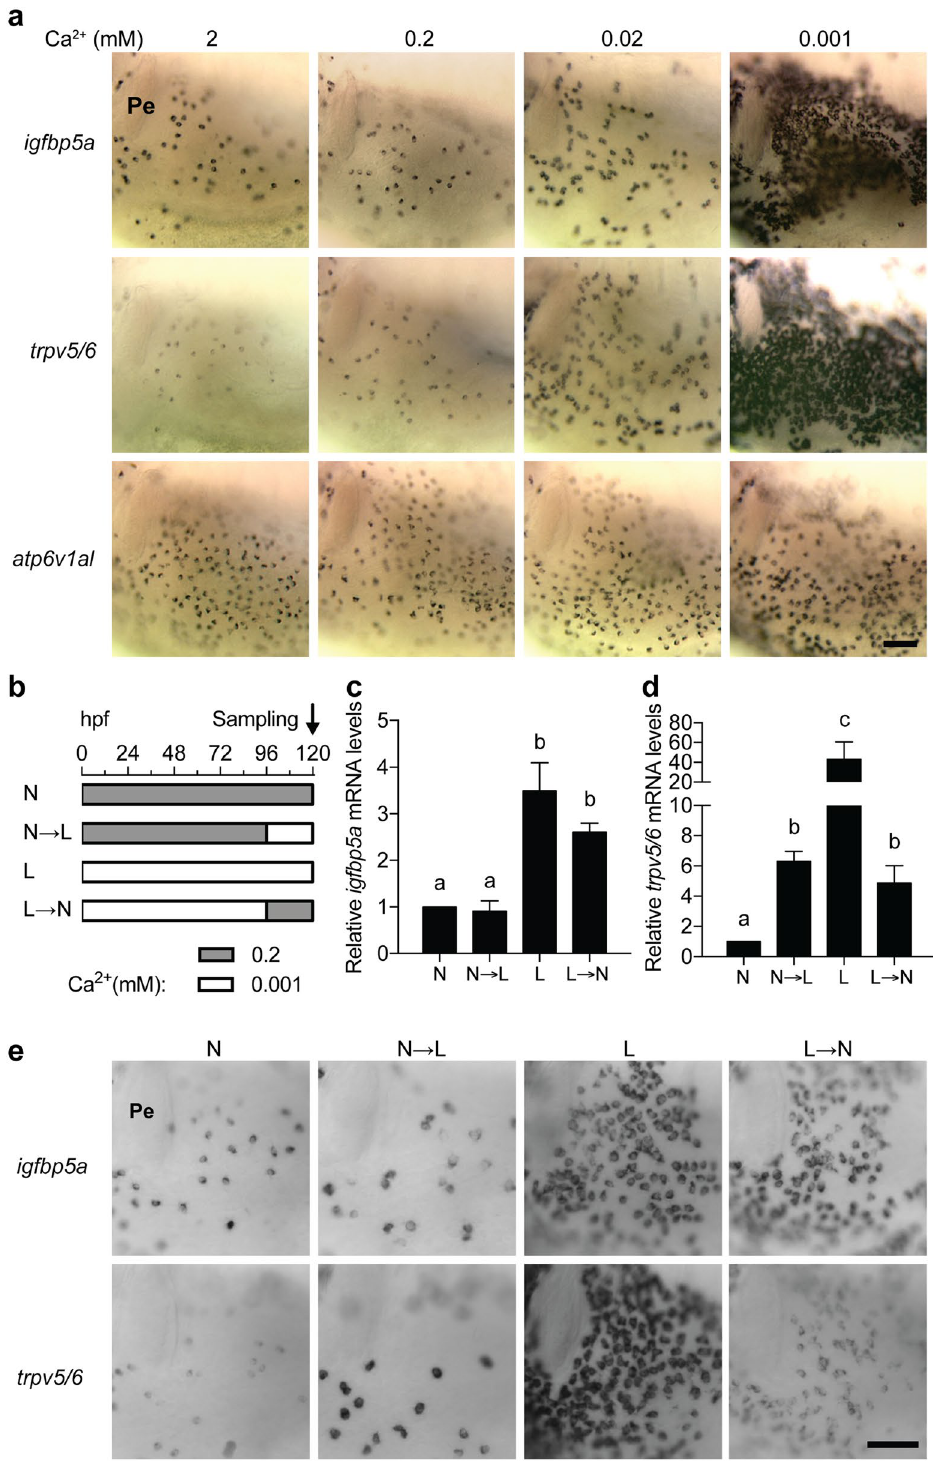
Figure 1. The igfbp5a gene is specifically expressed in NaR cells. ( a ) Wild type zebrafish embryos were raised in embryo rearing solution containing the indicated [Ca 2 + ] from 0 to 120 hpf (hours post fertilization) and analyzed by whole-mount in situ hybridization using the indicated probes. Images shown are the yolk sac region. Scale bar = 50 μ m. Unless specified otherwise, all in situ hybridization images shown hereafter are lateral views, anterior to the left and dorsal up. ( b – e ) The trpv5 / 6 and igfbp5a genes respond differentially to [Ca 2 + ] changes. The experimental design is shown in ( b ). The mRNA levels of igfbp5a ( c ) and trpv5 / 6 ( d ) were measured by qPCR and normalized by the β -actin mRNA levels. Data shown are mean ± SEM, n = 3. Different letters indicate significant differences at p < 0.05. ( e ) The larvae described in ( b ) were analyzed by in situ hybridization using the indicated probes. Representative images are